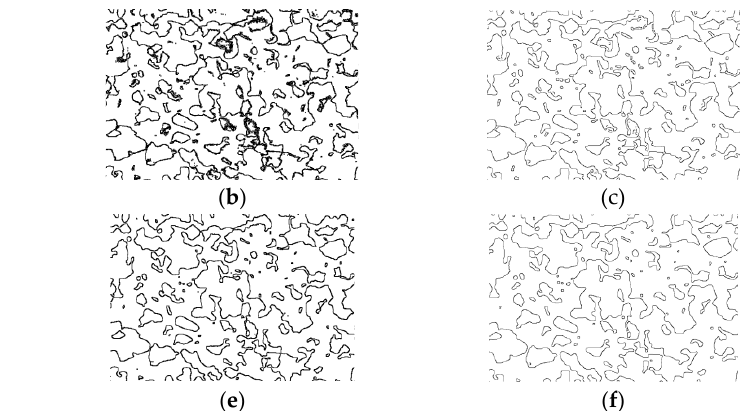
Figure 4. ( a – c ) A1La5 specimen processed at 1500 °C, scale 5 μ m, no filter: ( a ) SEM image, ( b ) image